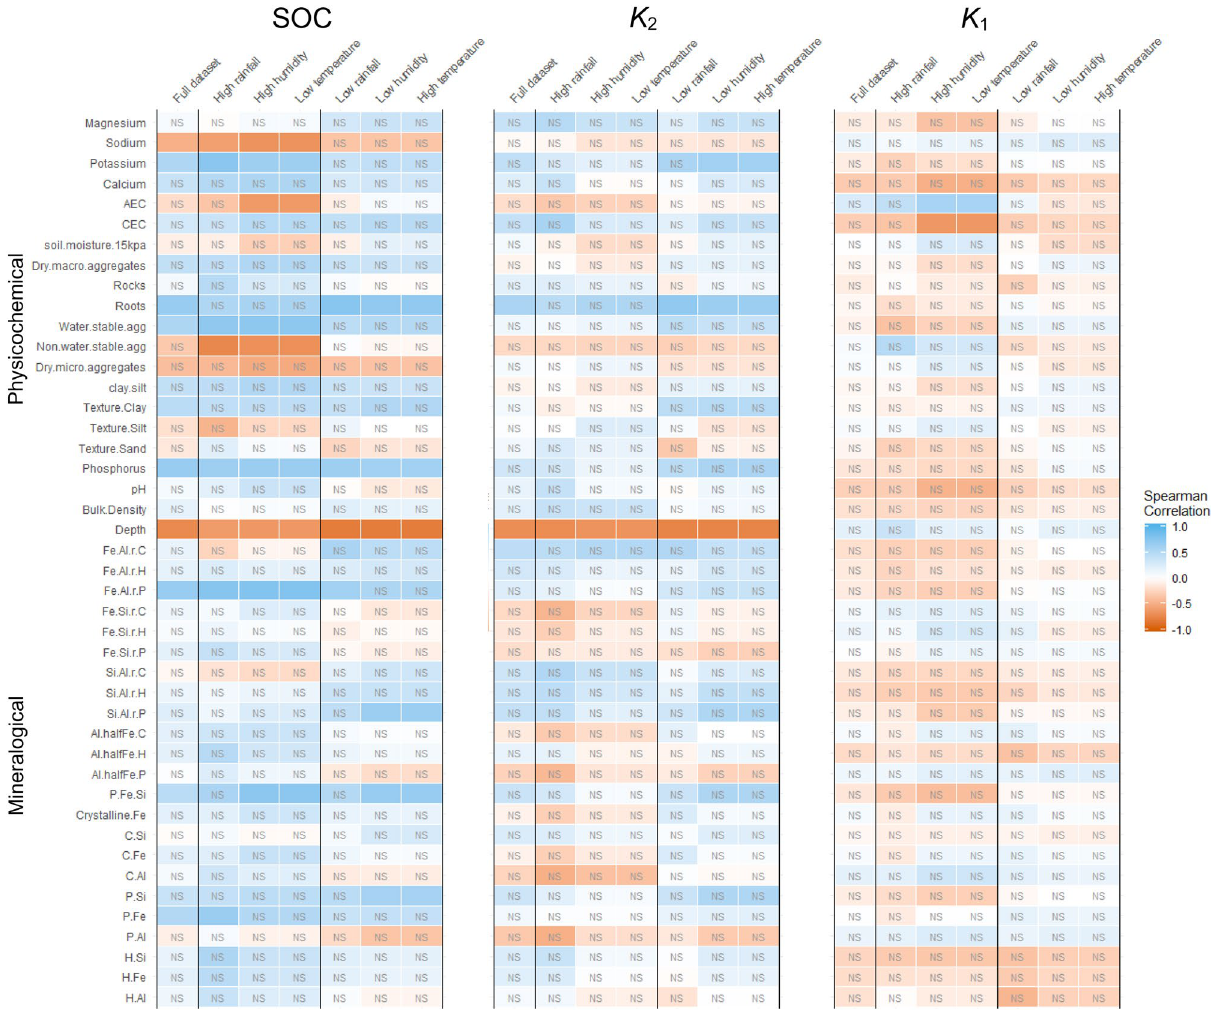
Figure 3. Physicochemical soil properties correlated to conditional residual variance within intercept-only linear mixed models of SOC content, the rates of fast pool C decay (k1) and slow pool C decay (k2). Residuals from LMM (1) for SOC, k 1 , and k 2 were parsed by climate, above and below the median of each climate variable, and assessed for spearman correlation to measured soil physicochemical properties. Correlations within a response variable that are greater than the Bonferroni adjusted α of all comparisons (0.05/308 = 0.000162) are labeled as non-significant